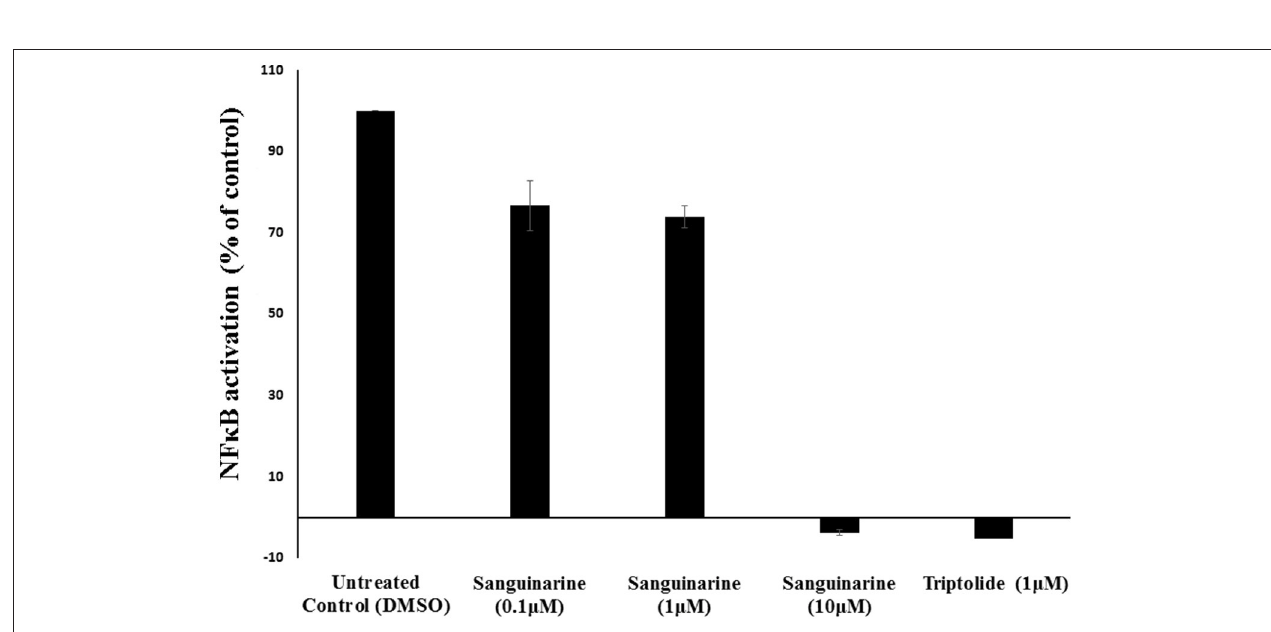
FIGURE 7 | Effect of sanguinarine on NF- κ B activity in comparison to the known NF- κ B inhibitor, triptolide, as positive control.